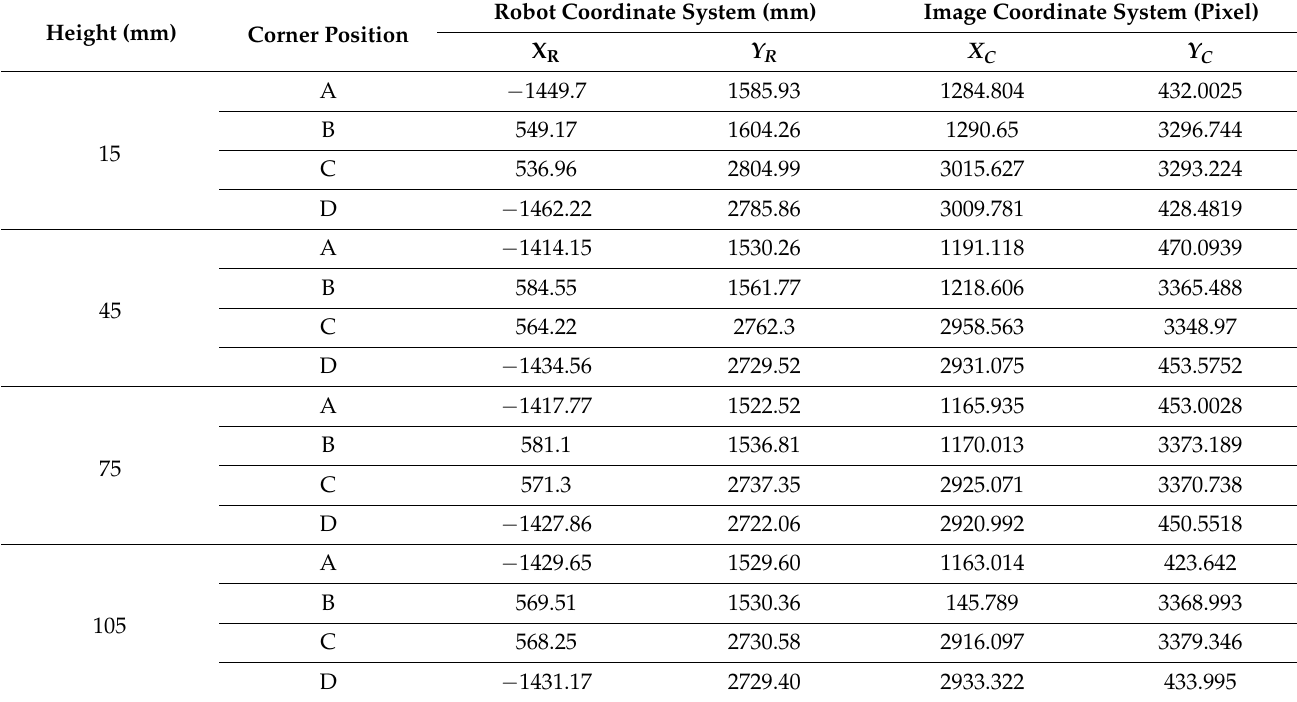
Table 3. Four-point calibration results.